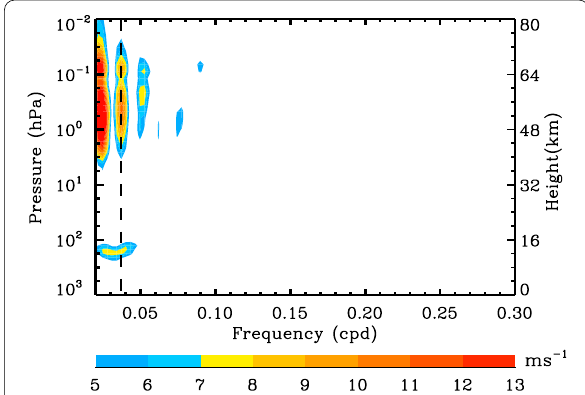
Fig. 6 Lomb–Scargle spectrum of zonal wind over Maui obtained from MERRA-2 reanalysis data. The dashed vertical line corresponds to a period of 27